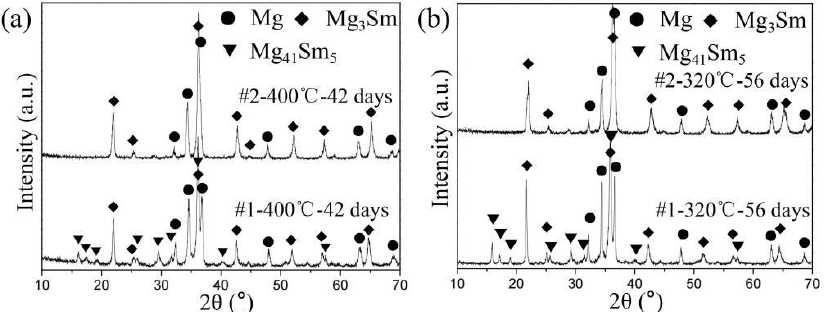
Figure 3. The BSE images of alloys #1 – #2 annealed at ( a , b ) 400 °C for 42 days and ( c , d ) 320 °C for 56 days.